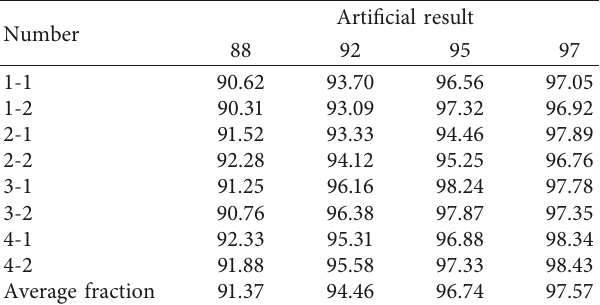
Figure 6: EBSD results diagram of 92% cube texture content samples. Table 4: Results of cube texture detection based on different methods